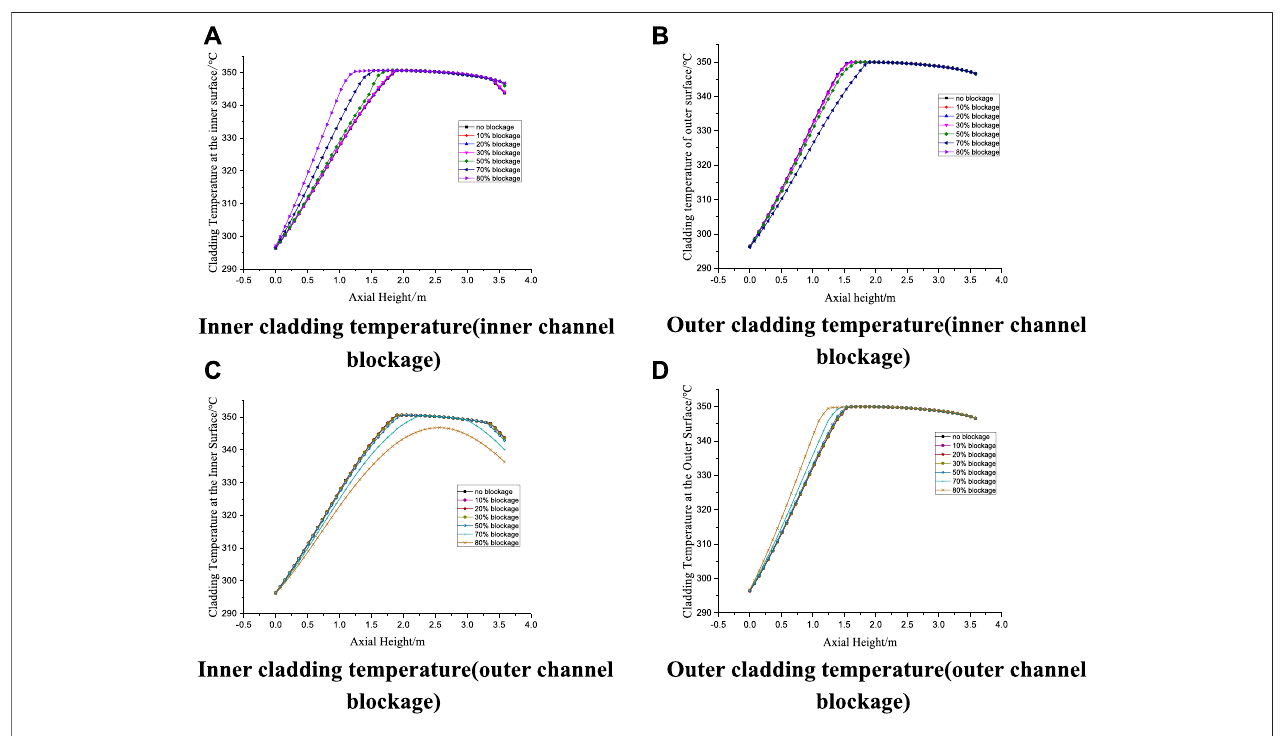
FIGURE 17 | Cladding temperature variation with axial height under different inner and outer channel blockage ratio.